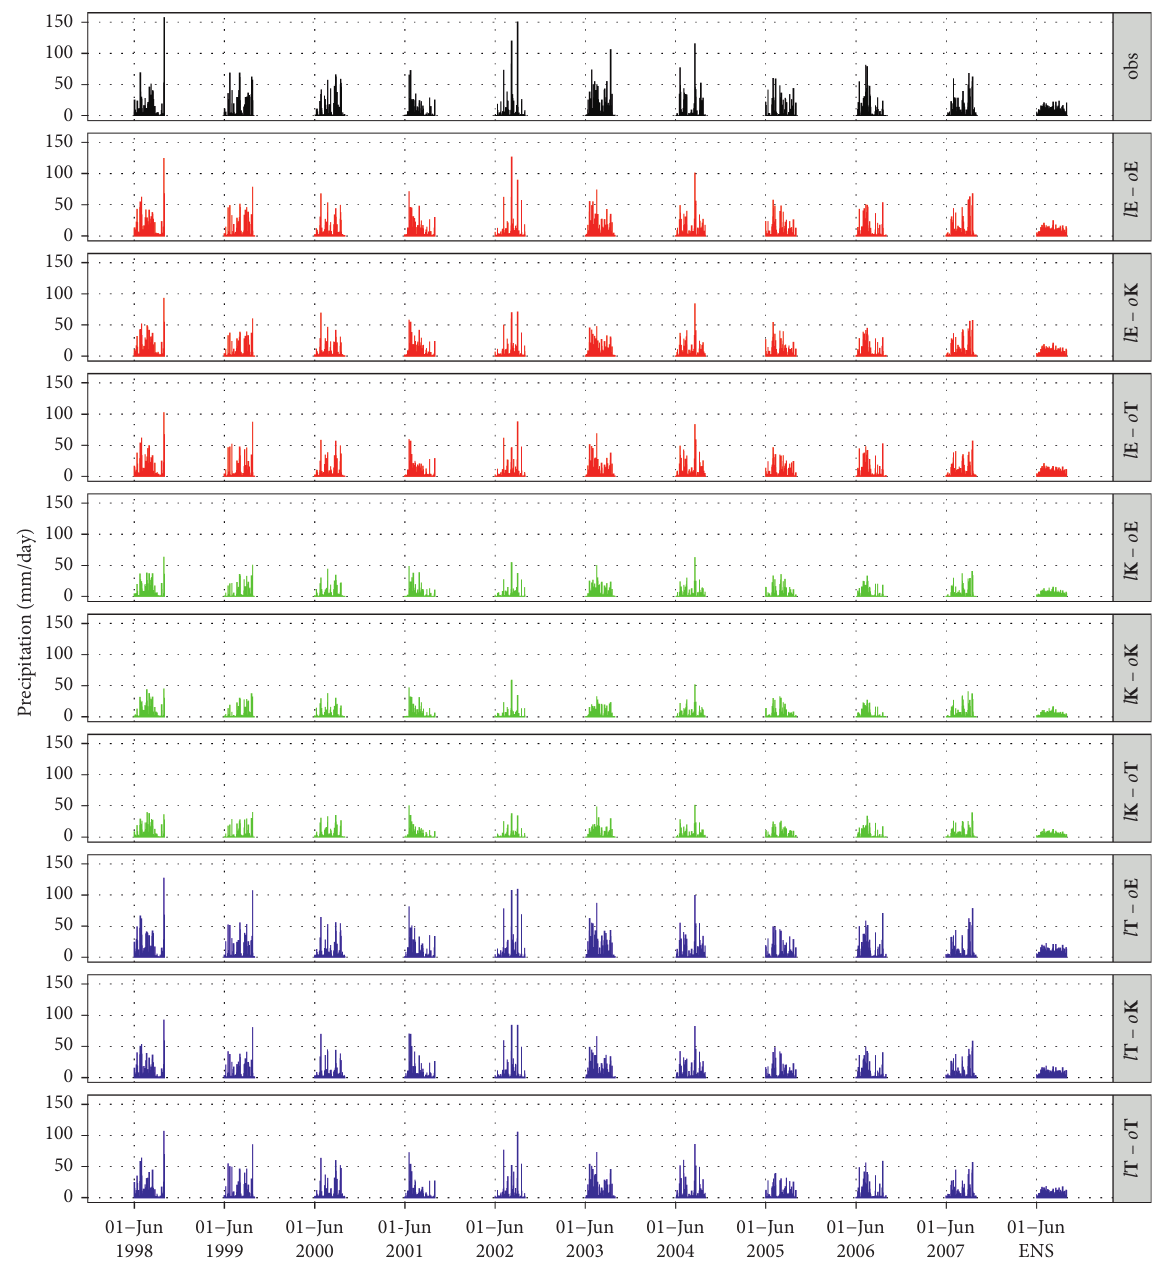
Figure 6: Time evolution of 56-station-averaged daily precipitation (mm/day) for the 10-year JJAS period (1998–2007) and the ensemble of 10 years derived from the in-situ observation and model simulations interpolated to the station